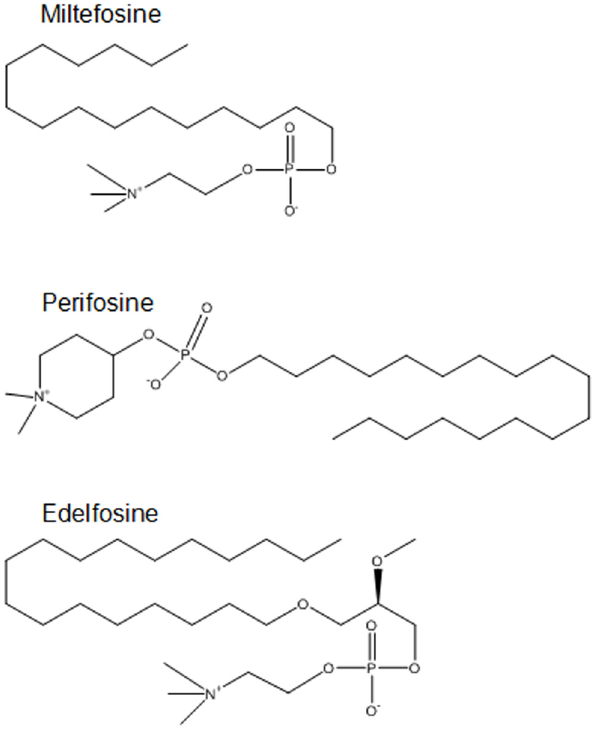
Figure 1. Structures of alkylphospholipid compounds used in this